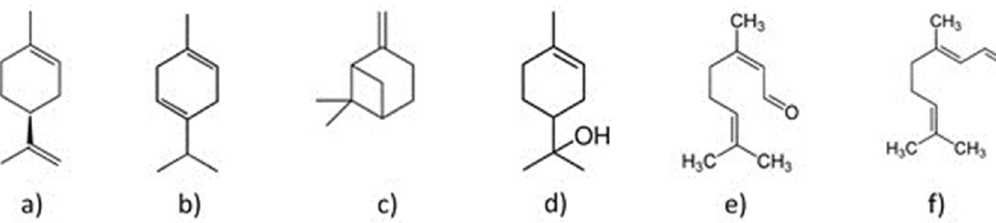
Figure 1. Compounds in the essential oil of Persian lime: ( a ) d-limonene, ( b ) γ -terpinene, ( c ) β -pinene, ( d ) α -terpineol, ( e ) neral, and ( f ) geranial.